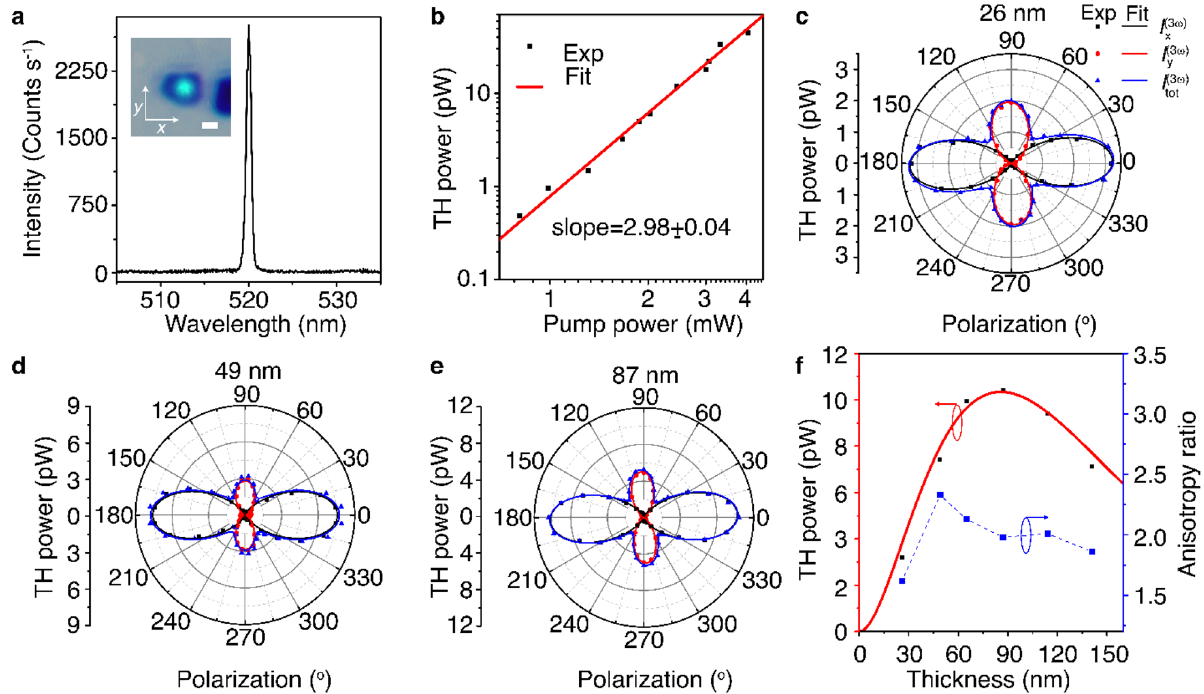
Figure 5. ( a ) THG emission spectrum from the 26 nm-thick abramovite flake. Inset shows the transmission microscope image of the THG emission from the illuminated area of the flake. Scale bar is 1 µm. ( b ) Log-scale plot of the measured TH power depending on the pump power. ( c ) Dependence of the TH power on the linear polarization angle of the pump beam for the 26 nm flake. ( d , e ) Polarization-dependent THG emission from two more flakes with thicknesses of 49 and 87 nm. ( f ) Evolution of the measured TH power (black data points) and THG anisotropy ratio (blue data points) as a function of the flake thickness. The red curve is the theoretical fit to the TH